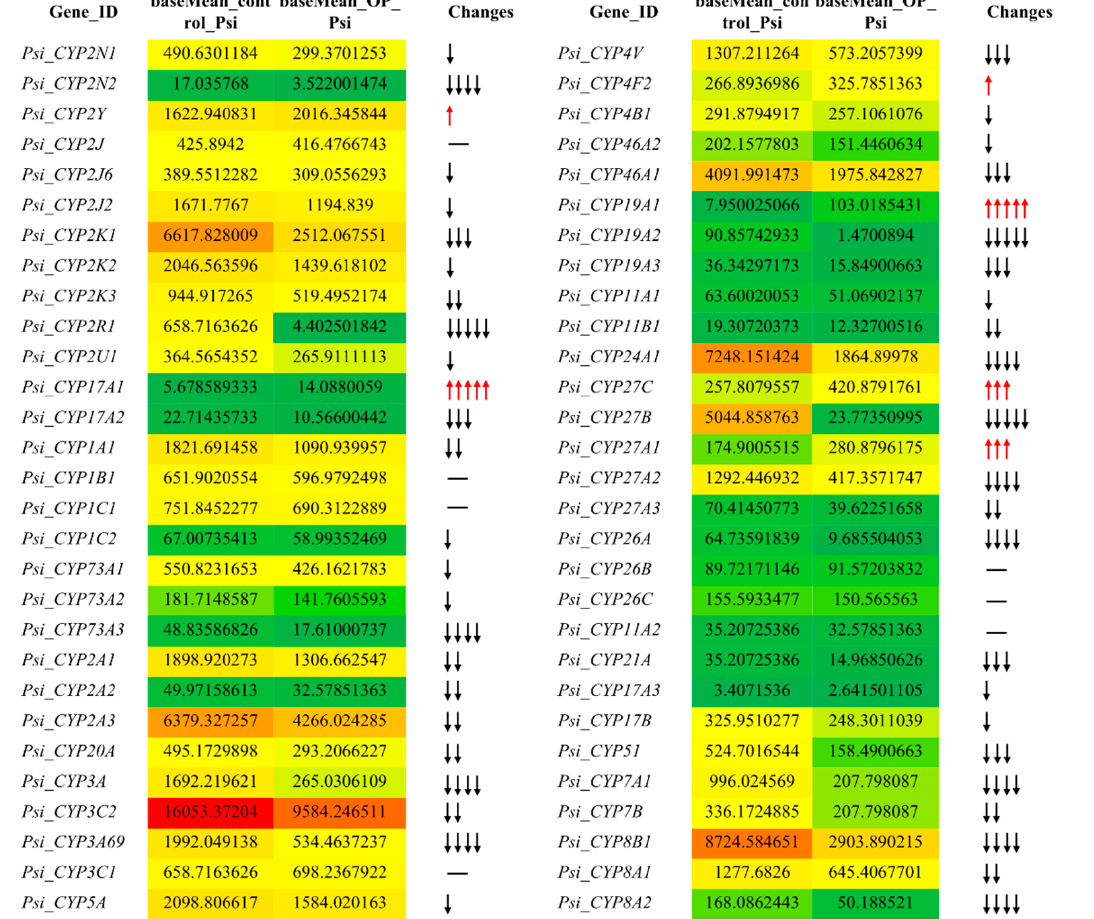
Table S1. CYP genes identified in this study. Figure S1. Phylogenetic tree generated by ML method. Figure S2. Phylogenetic analysis of CYP genes in Amur stickleback and other six fish species. Figure S3. Synteny analysis of CYP genes in several fish and other species. The position of CYP genes and neighboring genes on chromosomes are shown. Figure S4. Sequence alignment of the Group III CYPs in P. sinensis . Sequence alignment was performed by using ClustalW. Five conserved regions (C-Helix region, I-Helix region, K-Helix region, PERF motif region, and heme-binding region) are written in red. The 12 alpha helices are marked (from A to L) with green lines. Six substrate recognition sites (SRS1–6) are boxed with blue rectangles. Eight positive selective sites are presented in red